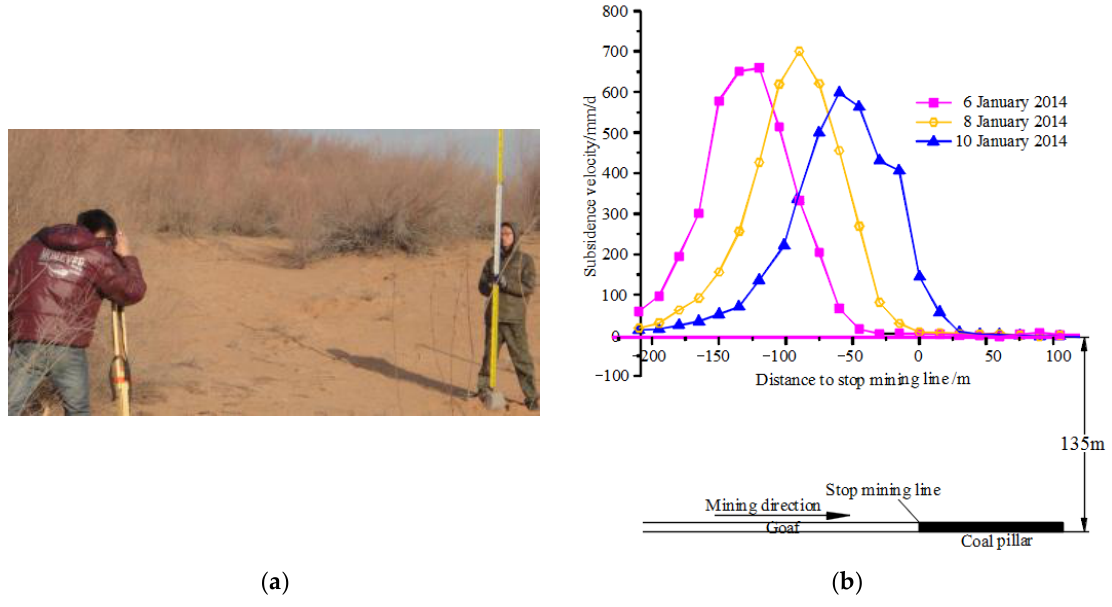
Figure 8. Monitoring method and data [8]. ( a ) Monitoring method, ( b ) monitoring data.